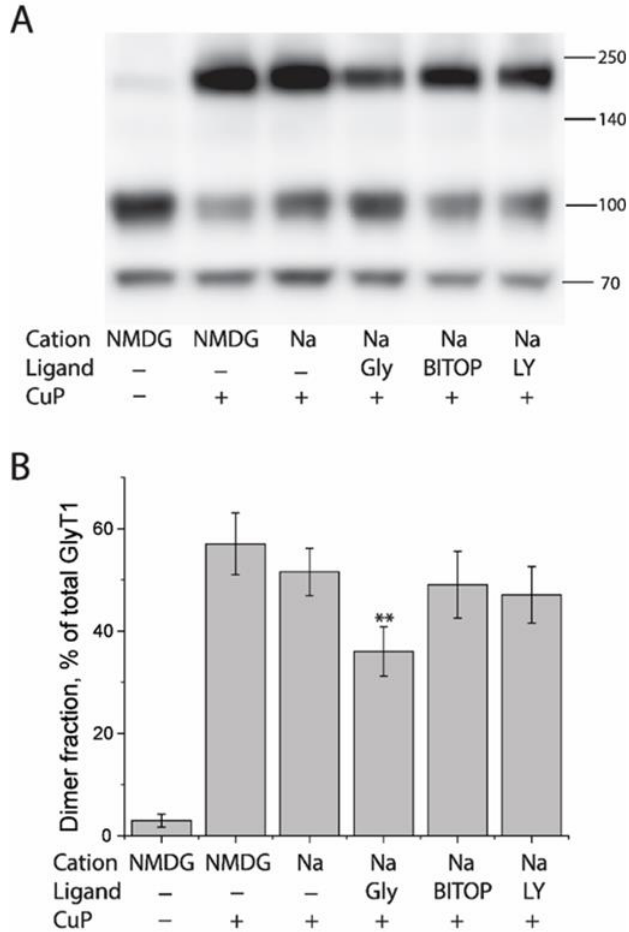
Figure 7. Influence of GlyT1 conformations on CuP cross-linking of L288C. ( A ) A representative immunoblot showing CuP cross-linking of L288C under different conditions. HEK293 cells stably expressing L288C were treated with 10 μM CuP in the absence or presence of the indicated cation (150 mM), glycine (200 μM), or ligand (10 μM) at 22 °C for 15 min. After quenching, L288C in total lysates was detected by immunoblot analysis. ( B ) Quantification of dimer fraction under indicated treatments. The fraction of dimers was expressed as a percentage of fully glycosylated dimers. All results are presented as mean ± SEM averaged from three independent experiments. ** p < 0.01 compared to the value obtained with L288C under CuP treatment in the presence of 150 mM NMDGCl. Gly, glycine; BITOP, bitopertin; LY,